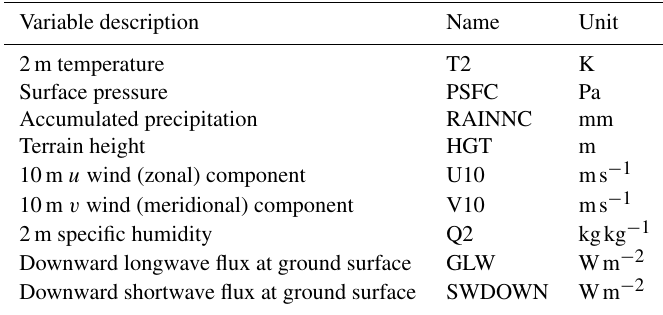
Table 2. Meteorological data from the WRF model used for simulation. Adapted from Pandit et al. (2019). Variable